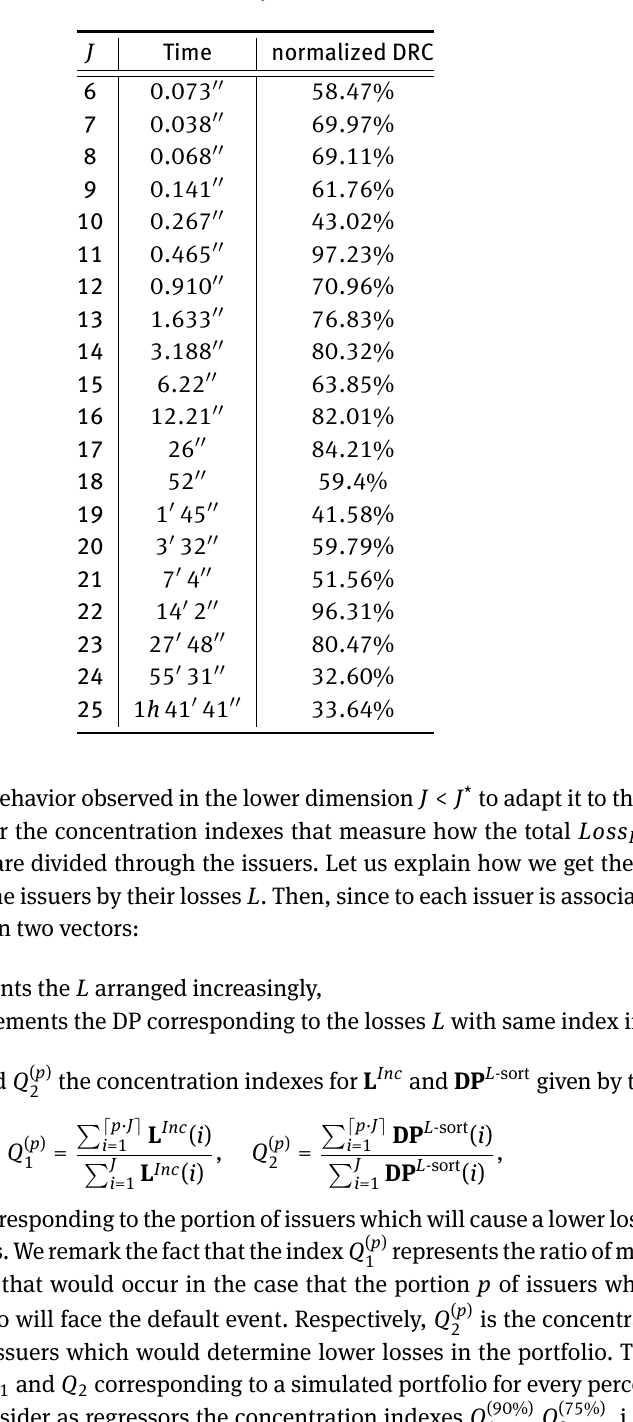
L ( i ) , later on it will be i =1